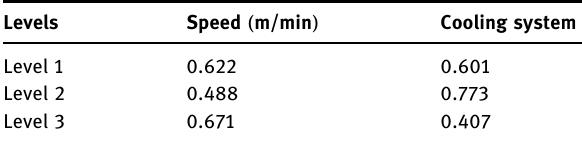
Table 6: Grey relational degrees of the factor levels for conventional insert tool